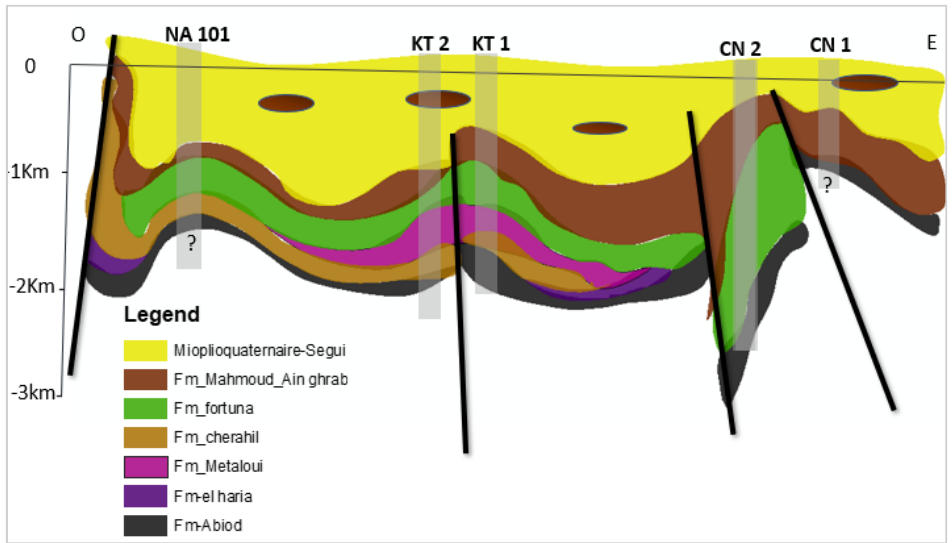
Figure 5. Cross-section AA ’ between petroleum wells in the West-East direction (modified, ETAP(Tunisian National Oil Company, 1990).